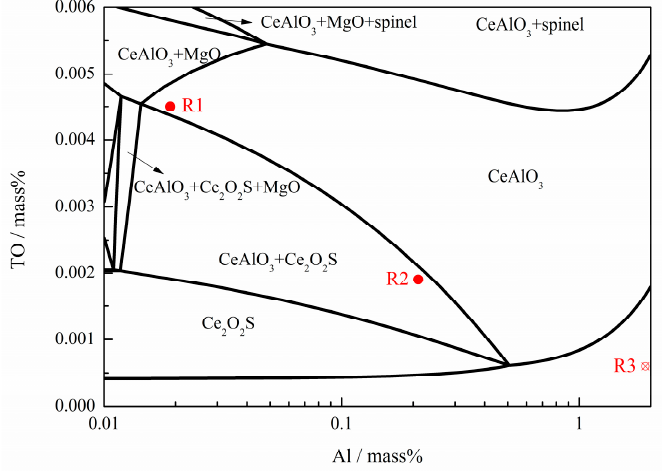
Figure 5. Stability diagram in the Fe-10%Mn-0.001%Mg-0.015%S-0.015%Ce-Al-O system at 1873 K.